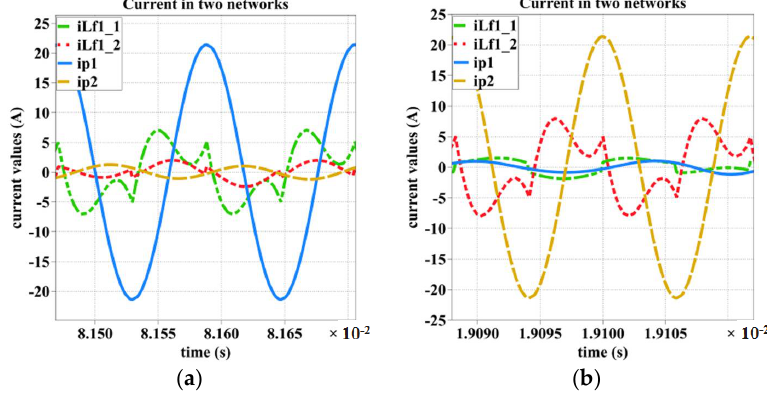
Figure 6. Current variation in multiple legs inverter. ( a ) First pad is coupled; ( b ) Second coil is coupled.